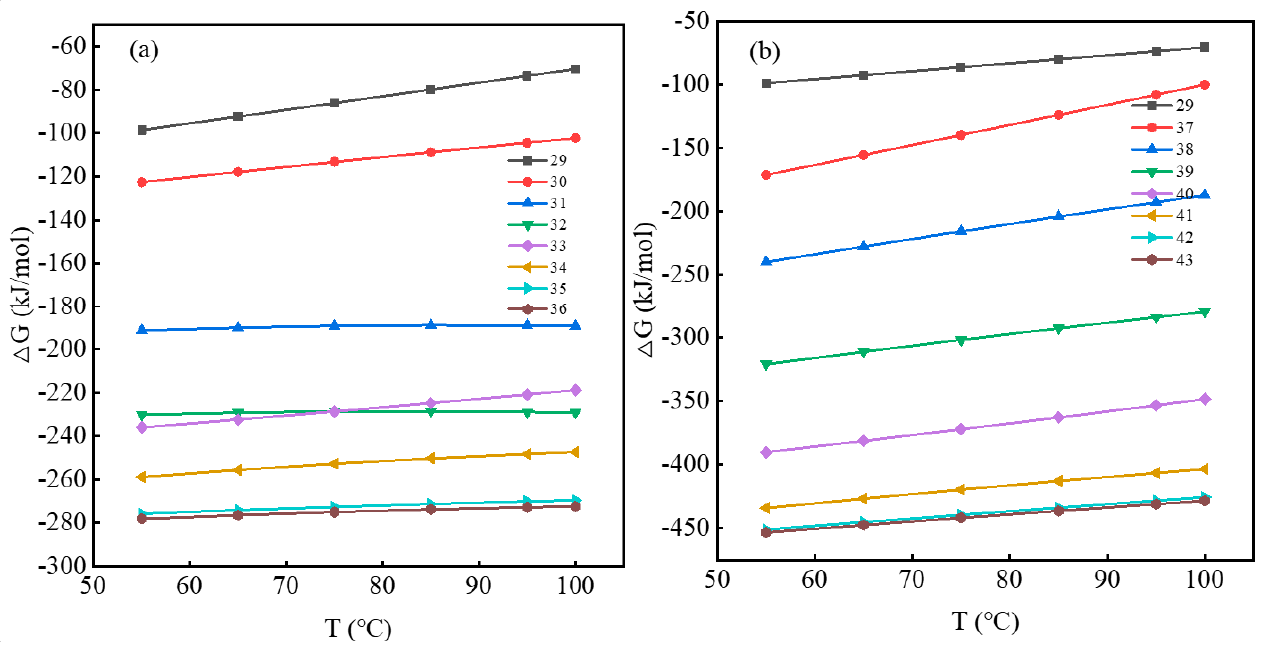
Figure 3. ∆ G change curve with T: ( a ) Equations (29)–(36); ( b ) Equations (29) and (37)–(43).